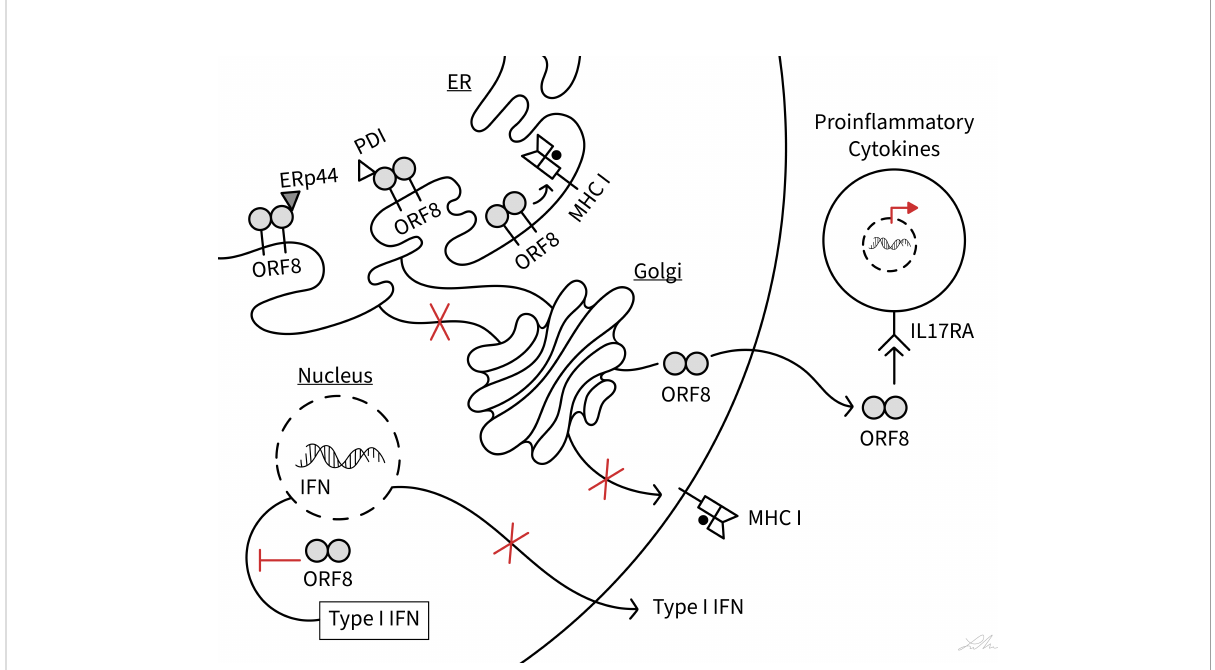
FIGURE 2 Schematic diagram showing interferences of SARS-CoV-2 ORF8 with various host immune functions. The diagram illustrates the action of ORF8 on MHC class I antigen presentation, ER stress (PDI and ERp44), type I IFN signaling pathway, and IL-17 signaling pathway (IL17RA). See text for ORF8 soluble and membrane-bound